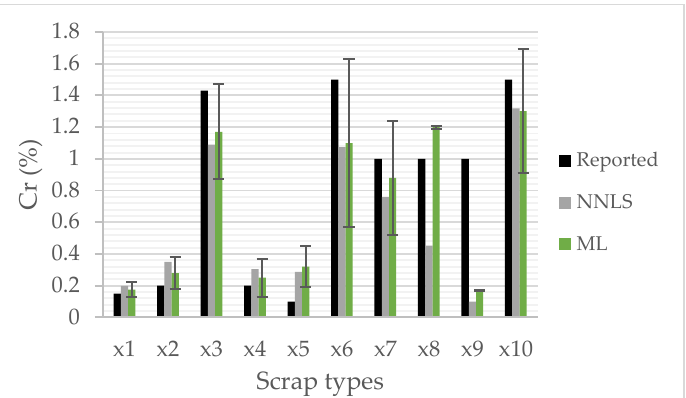
Figure 7. Comparison between the reported Cr concentration and calculated ones in scrap (x1– x10).